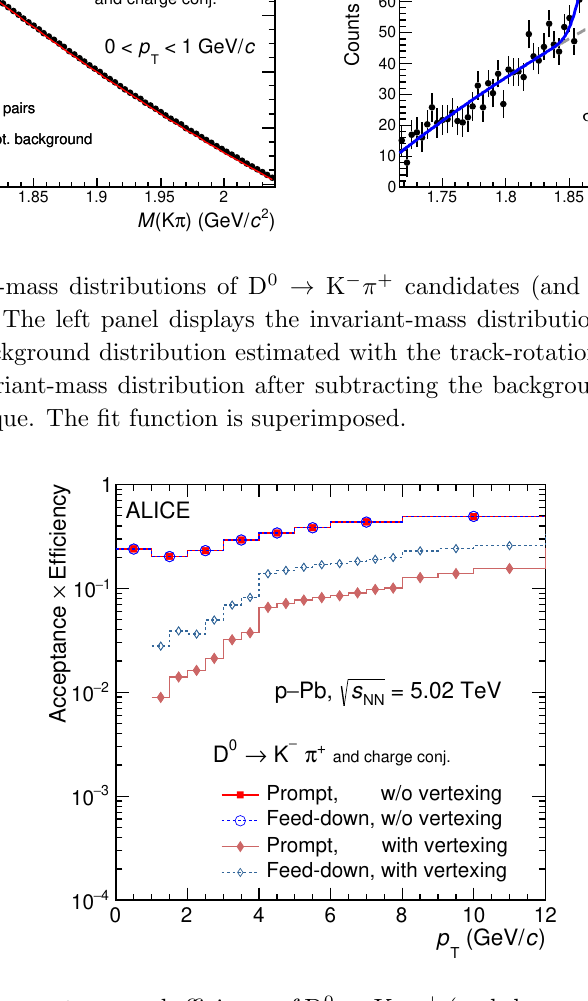
Figure 4 . Product of acceptance and e(cid:14)ciency of D 0 ! K (cid:0) (cid:25) + (and charge conjugates) in p{Pb col- lisions for the analyses with and without reconstruction of decay